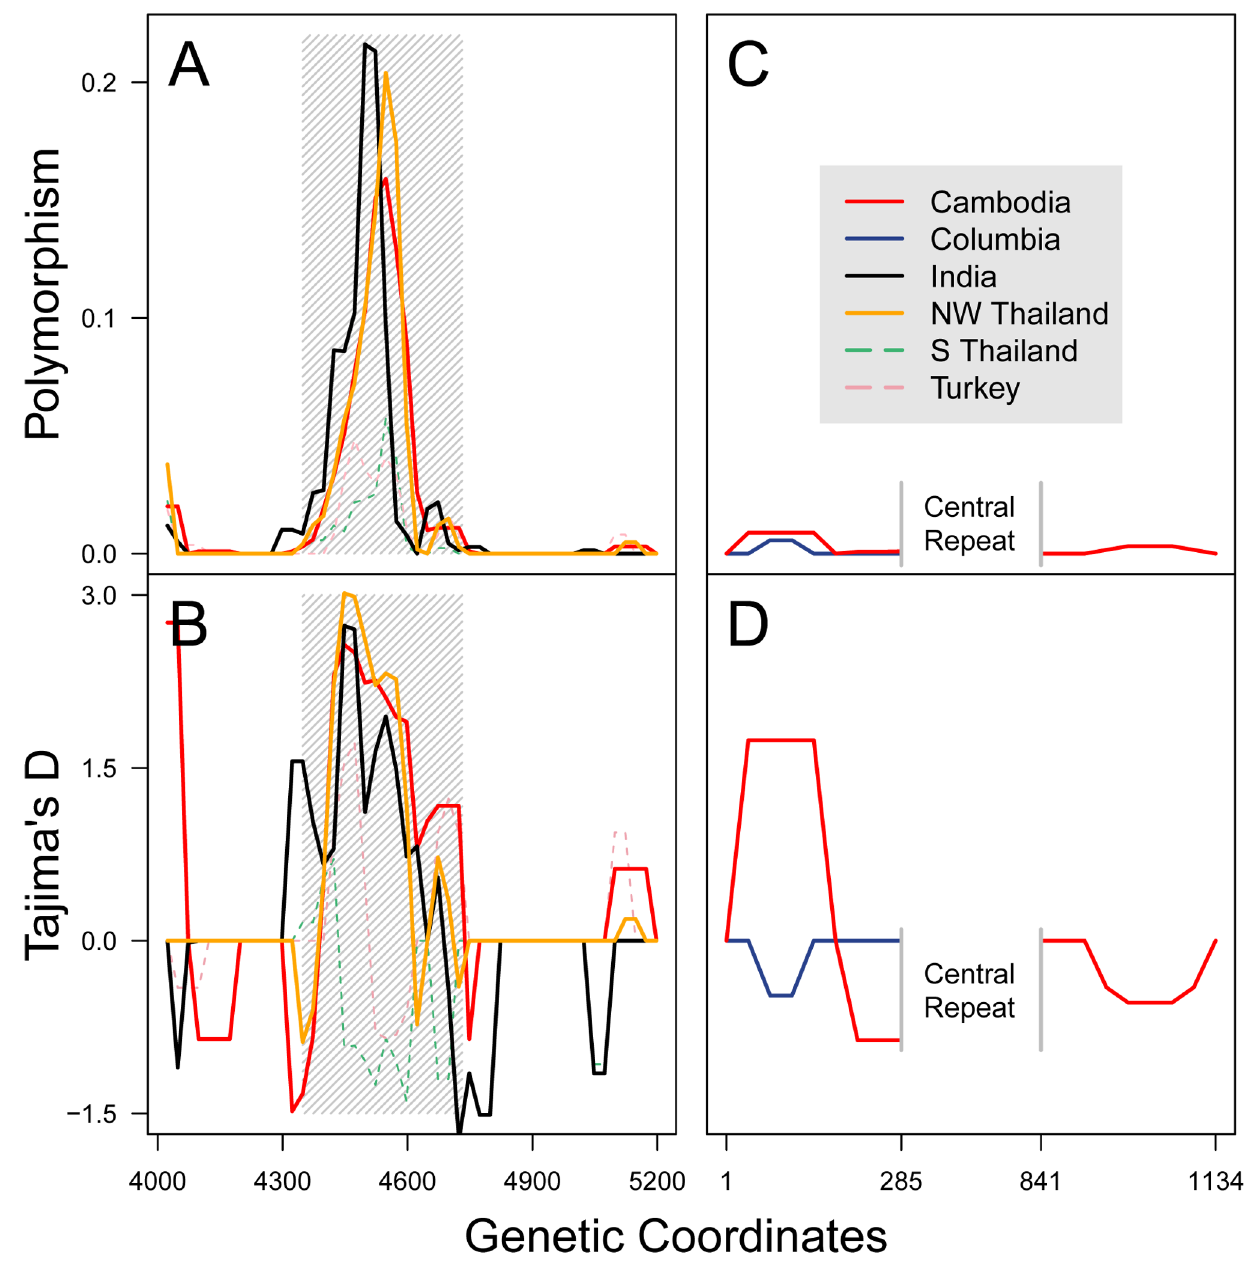
Figure 3. Nucleotide diversity and Tajima’s D across the pvmsp-1 42 kDa region and the whole pvcsp gene. Polymorphism (nucleotide diversity, p ) ( A ) and Tajima’s D ( B ) were calculated across the pvmsp-1 amplicon for five diverse populations. A sliding window (50 bp window and 25 bp step size) was used to achieve a high resolution analysis. Grey hatches demark the intervening region (nucleotides 4348–4731). For pvcsp , N- terminal and C-terminal non-repeat regions were analyzed for nucleotide polymorphism ( C ) and evidence of balancing selection ( D ) using a sliding window. Putatively panmictic populations are marked with a solid line, while populations known to be subject to strong selective forces are marked with dotted lines. All coordinates are based on Sal1 pvmsp-1 and pvcsp reference